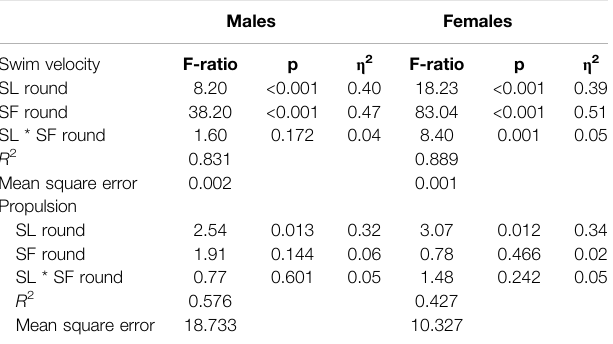
TABLE 3| Male andfemaletwo-wayANOVAsconsideringswimmingvelocity and propulsion by SL round, SF round, and their interaction (see Figure 1 ). Males